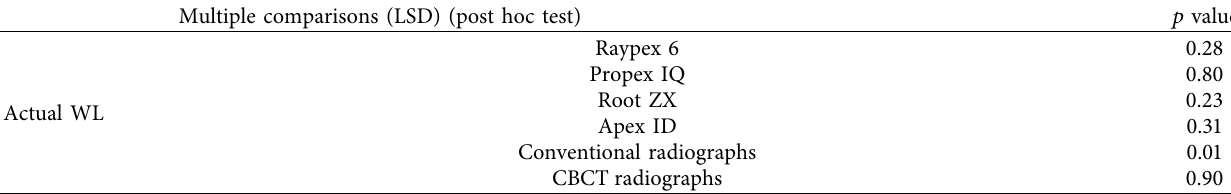
Table 3: One-way ANOVA for comparison of the WL values measured obtained using the different techniques. df � 9, F value � 1.53. The actual WL value was closest to the value obtained with CBCT ( p < 0 . 90), followed by Propex IQ ( p < 0 . 80). However, the actual WL value was significantly different from that obtained with conventional radiographs ( p < 0 .